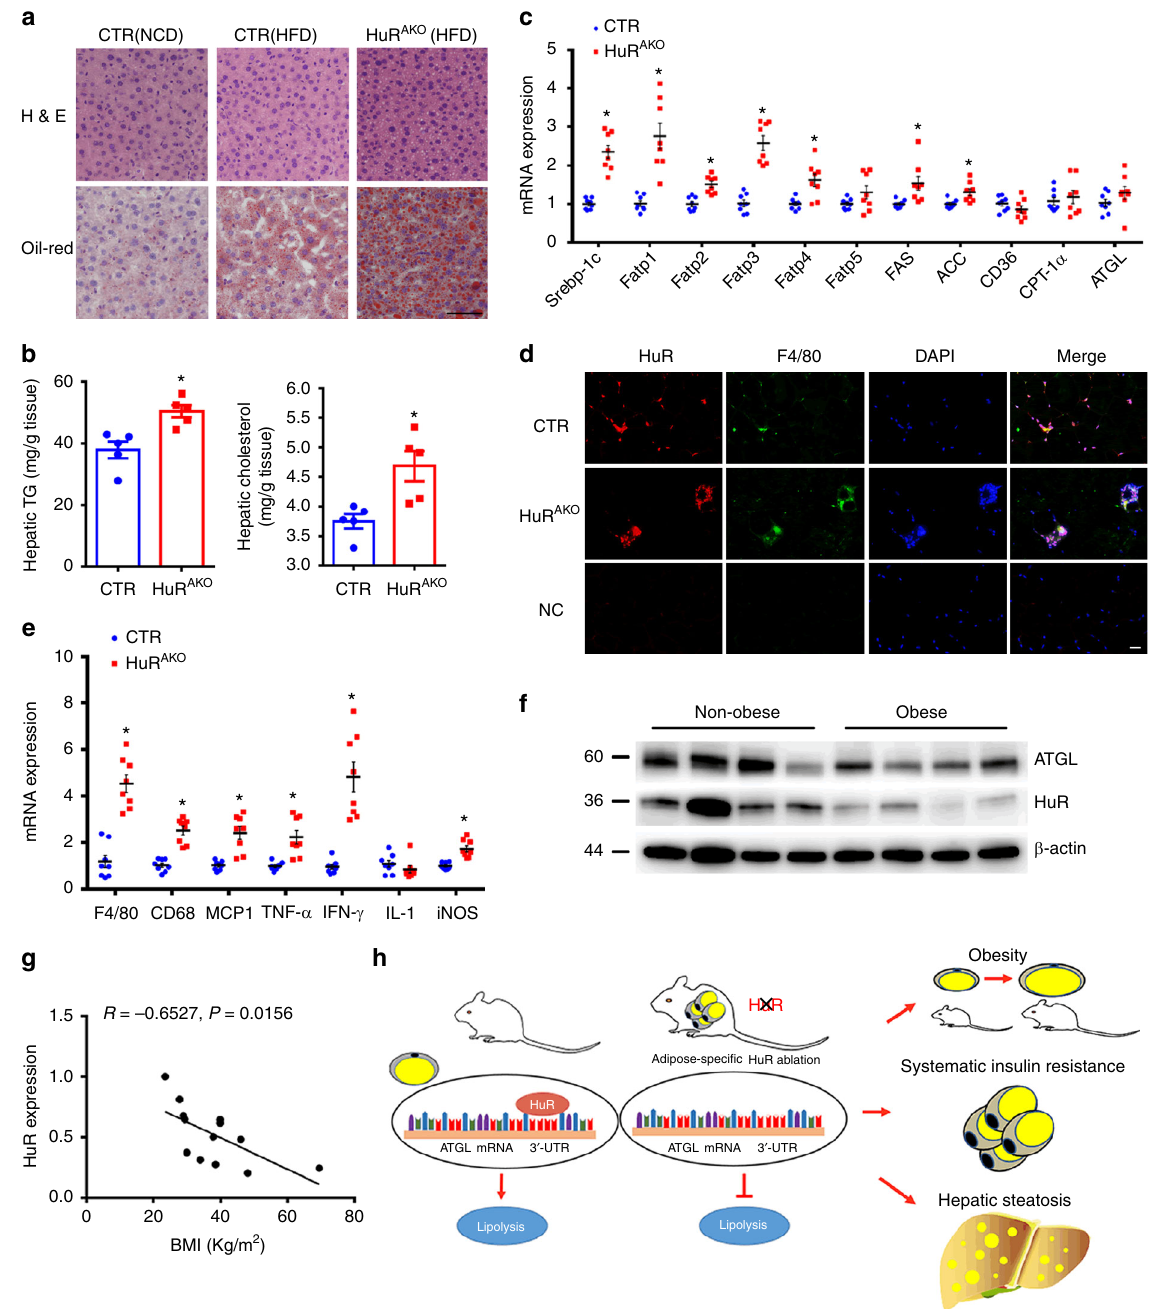
Fig. 7 HFD-fed HuR AKO mice show increased hepatosis. a Representative images of H&E- and Oil-red O-stained sections of liver tissues from NCD-induced control, HFD-induced control and HuR AKO mice. Scale bar: 50 μ m. b Levels of hepatic cholesterol and triglycerides in livers of control and HuR AKO mice fed an HFD ( n = 5), *comparison of HuR AKO vs. control. c qPCR analysis of mRNA levels of lipogenesis-related genes in liver from control and HuR AKO mice fed an HFD ( n = 8), *comparison of HuR AKO vs. control. d Immuno fl uroscence staining of HuR and F4/80 in adipose tissue. DAPI: nucleus. Scale bar: 20 μ m. e qPCR analysis of mRNA levels of in fl ammation-related genes in livers from control and HuR AKO mice fed an HFD ( n = 8), *comparison of HuR AKO vs. control. f Western blot analysis of ATGL and HuR protein levels in adipose tissues from normal and obese patients ( n = 4 for normal or obese individuals). g Correlation of normalized HuR protein expression and BMI in adipose tissues of obese patients (total 13 samples). h Schematic diagram about the mechanism of HuR in adipose tissue and obesity. Data are represented as mean ± SEM. Signi fi cance was determined by Student ’ s t test analysis and Pearson ’ s correlations, * P < 0.05. Source data are provided as a Source Data fi